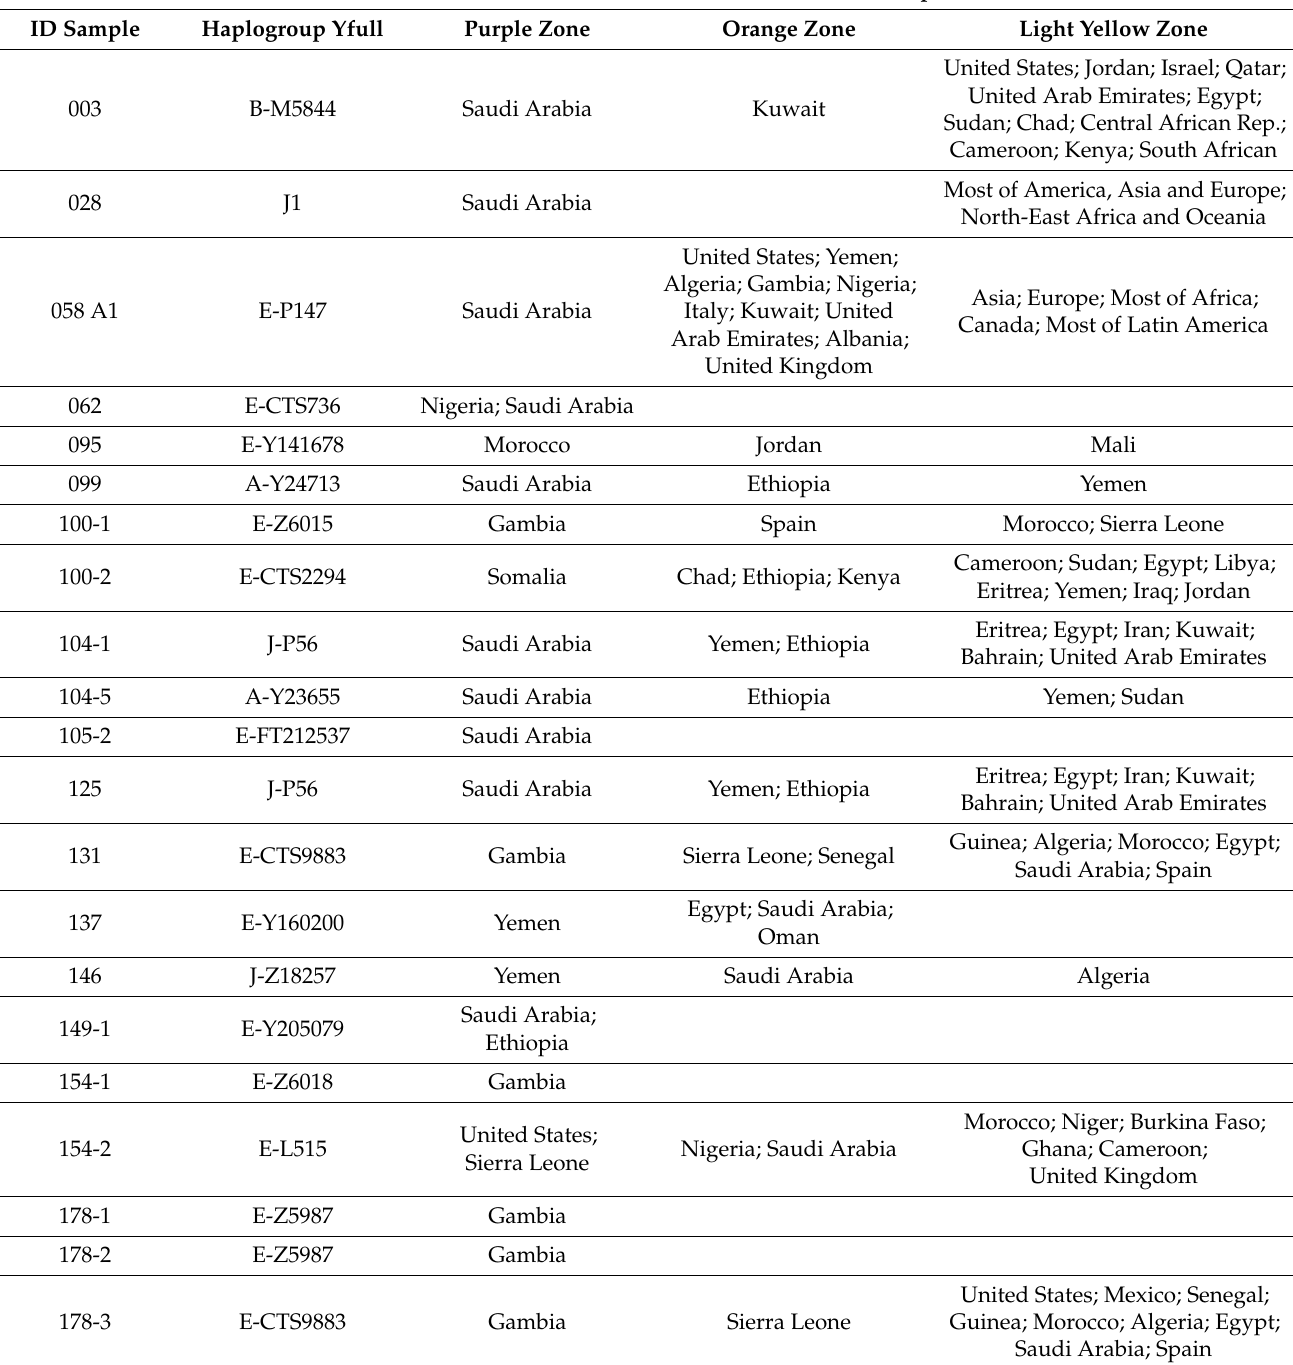
Table 4. ID sample, haplogroup using Y full nomenclature, world distribution of haplogroups observed by heatmaps. Purple, orange, and light-yellow colors refer to greater, intermediate, and less presence of that specific haplogroup,